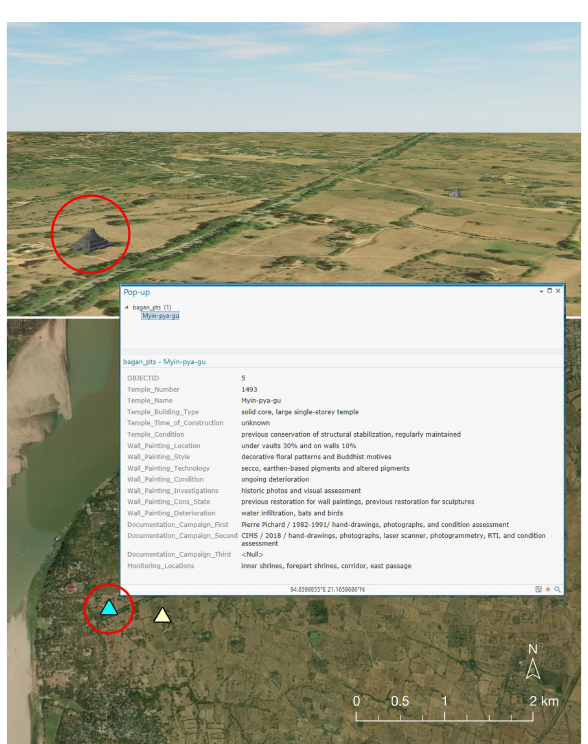
Figure 9. Temple and Wall painting metadata.